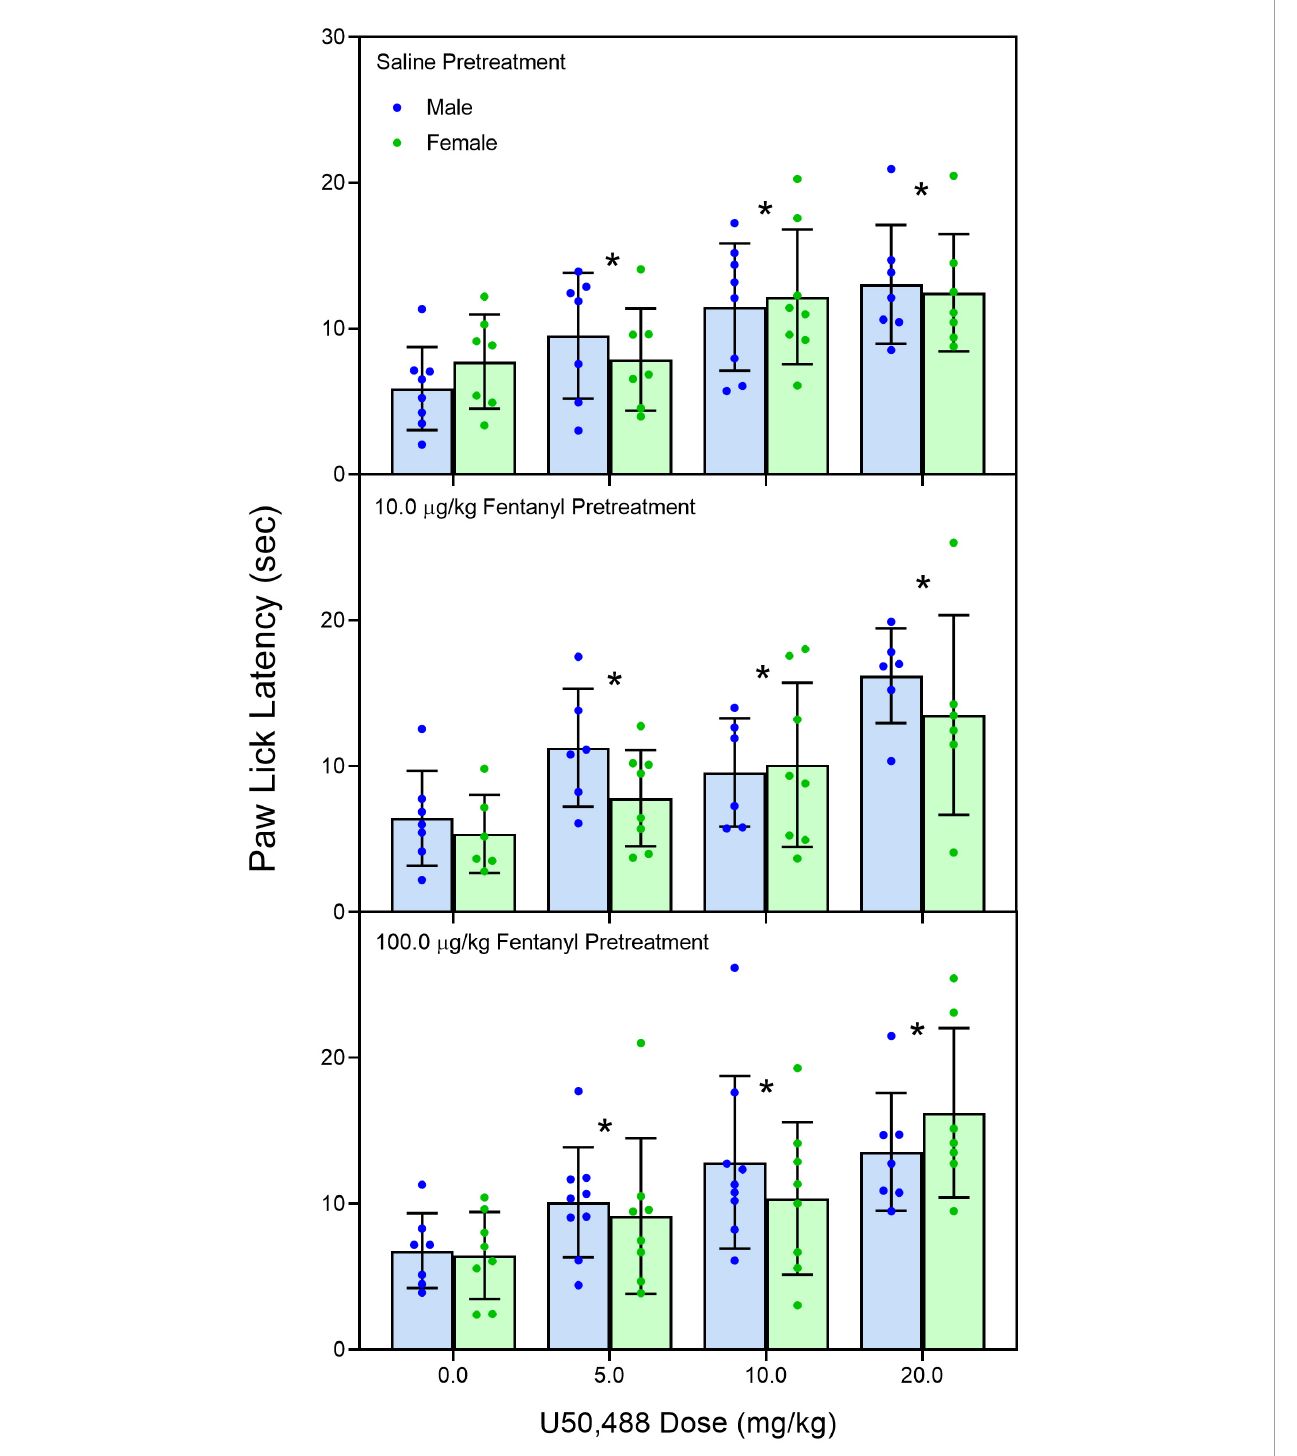
FIGURE4 Mean (+SE) baseline paw-lick latencies of PD 60 male and female rats ( n = 7–8/sex). Rats were pre-treated with fentanyl (10 or 100 µ g/kg) or saline from PD 4 to PD 9 and injected with U50,488 (0, 5.0, 10, or 20 mg/kg, sc) on PD 60. *Significantly different from 0 mg/kg morphine.